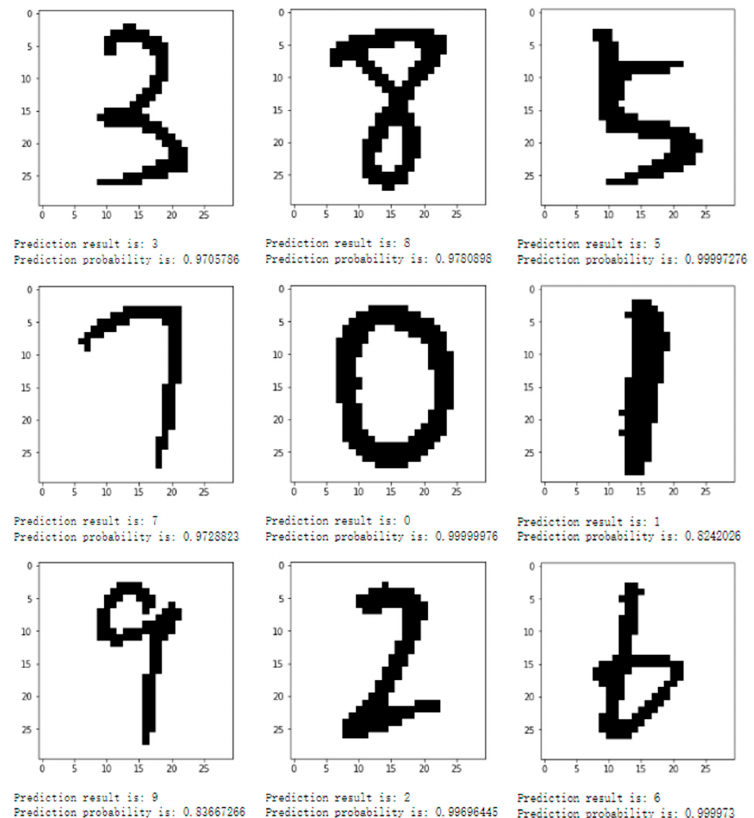
Figure 12. Recognition results of the accelerator on the MNIST data